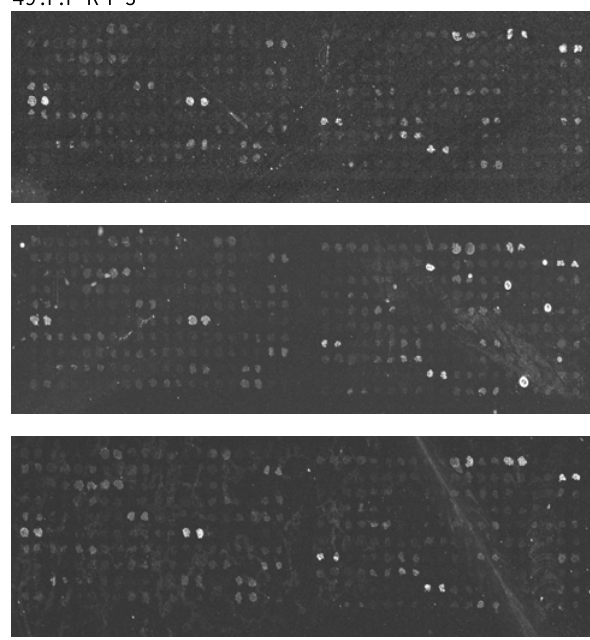
Figure 3: Oligonucleotide microarray replicate hybridization profiles resulting from hybridization with BOX-PCR amplification products from deer isolate